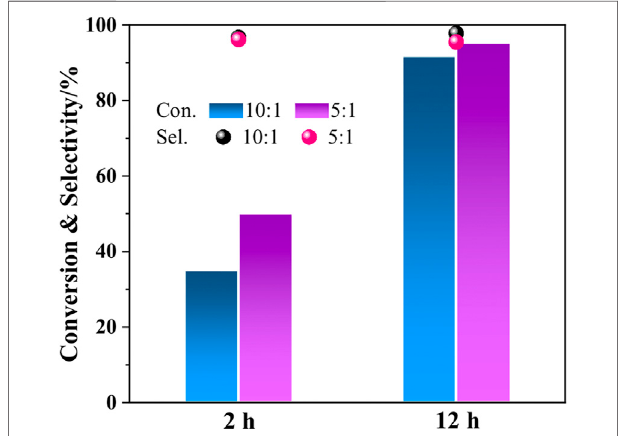
FIGURE 3 | Evaluation results before and after solvent evaporation